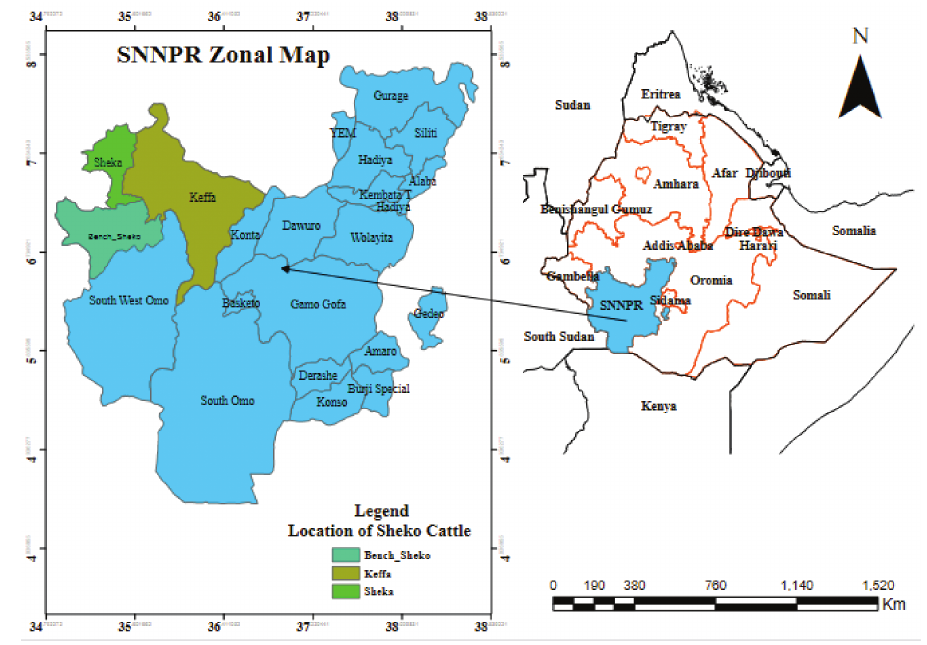
Figure 2: Map showing location of Sheko cattle (Bench-Sheko, Keffa and Sheka zones), SNNPR: Southern Nations Nationalities and Peoples